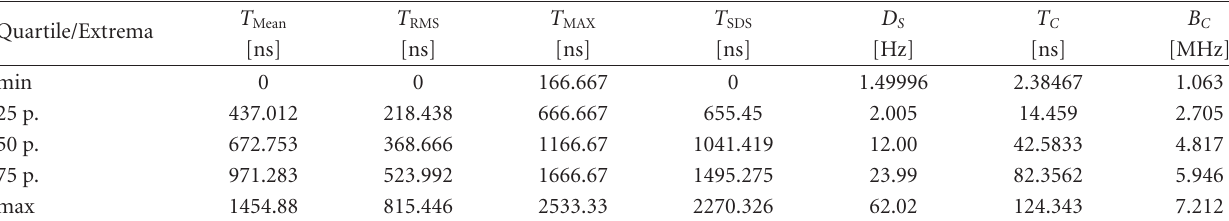
Table 2: 700 MHz channel metrics.